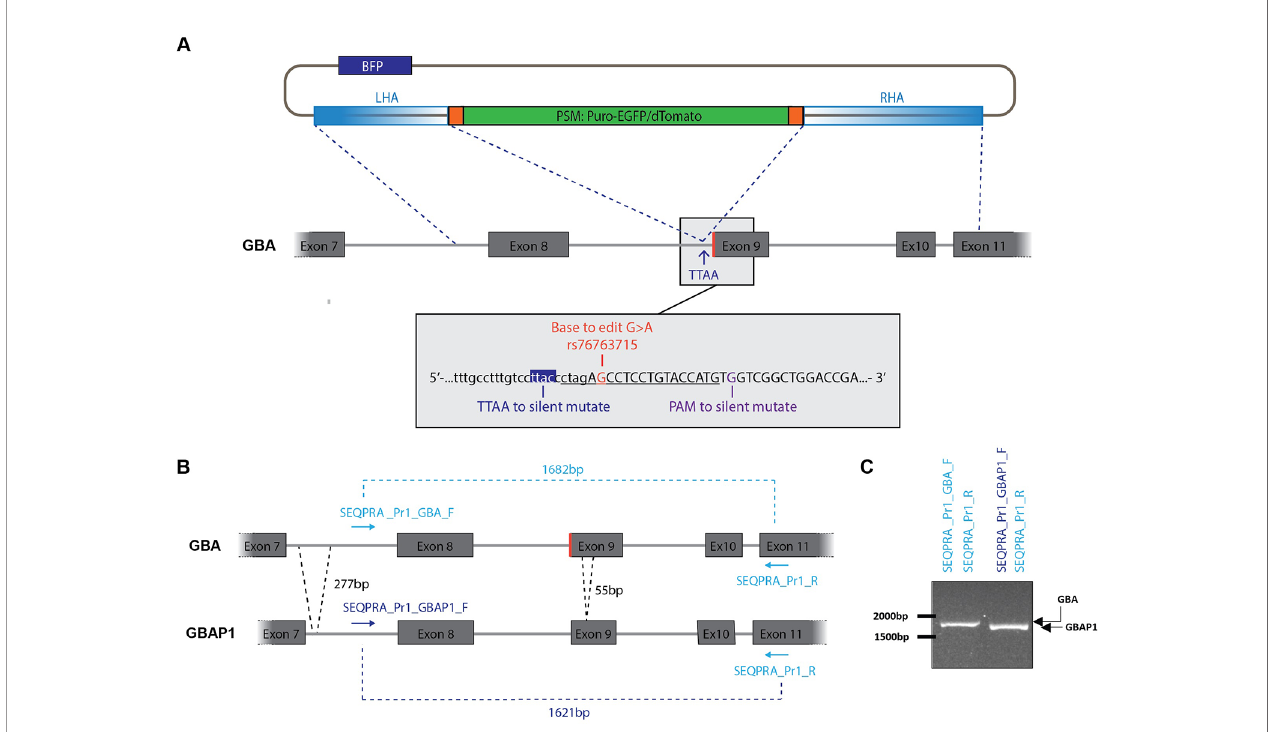
FIGURE 1 | Construction of donor vector for homology directed repair (HDR). (A) The left homology arm (LHA) and the right homology arm (RHA) ampli fi ed from genomic DNA are fl anking the positive selection module (PSM) which encodes a puromycin selection cassette and either EGFP or dTomato. A BFP, located in the backbone of the vector, allow to identify random integration events. Grey box: Genomic DNA sequence surrounding the mutation rs76763715. The sequence underlined is recognized by the sgRNA and followed by the PAM motif. Two nucleotides will be mutated within the RHA: C > A to generate a TTAA site, G > C in the PAM motif to avoid subsequent recognition after editing. Exons are in uppercase and introns in lowercase. (B) Strategy to amplify speci fi cally GBA over GBAP1 for construction of the donor vector. GBAP1 presents two deletions in its sequence compared to GBA : a 277 bp deletion in intron 8 and a 55 bp deletion in exon 9. (C) Validation of the speci fi city of selected SEQPRA primers. Visualization on an agarose gel allows to discriminate the amplicon of GBA from GBAP1 after PCR ampli fi cation with the selected